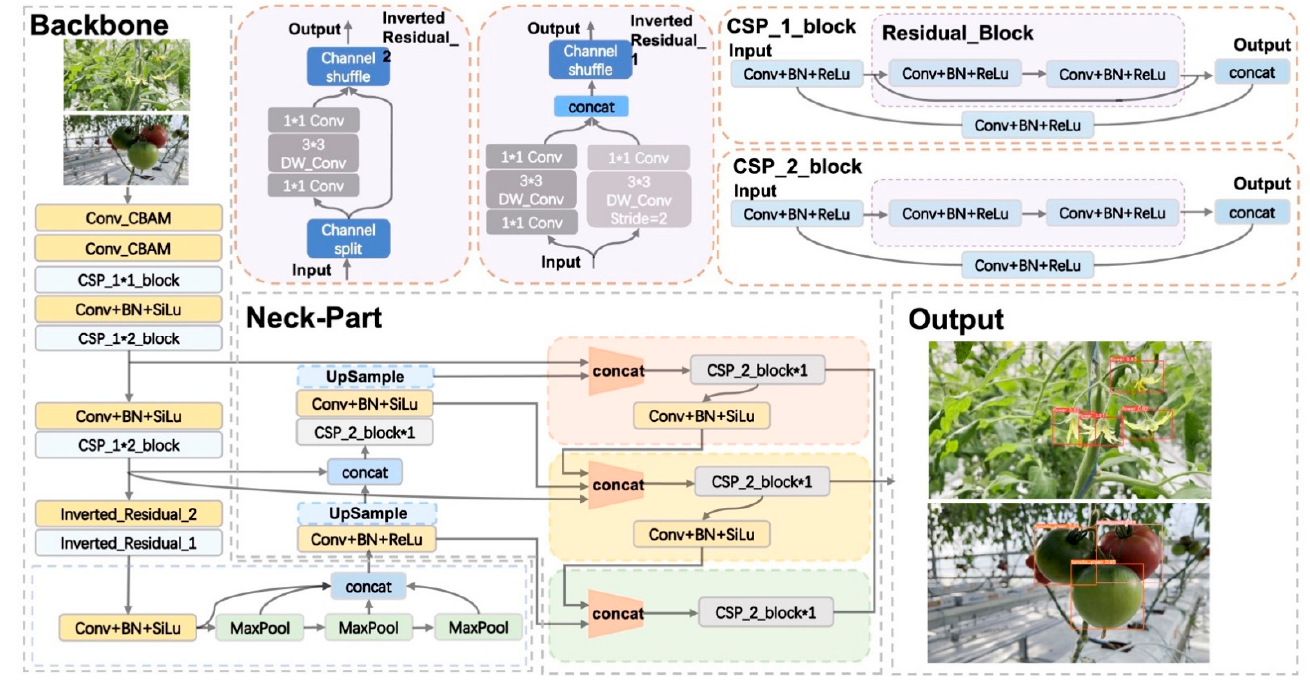
Figure 6. The structure of the object detection part network of YOLO-deepsort. Table 2. The parameters of YOLO-deepsort.